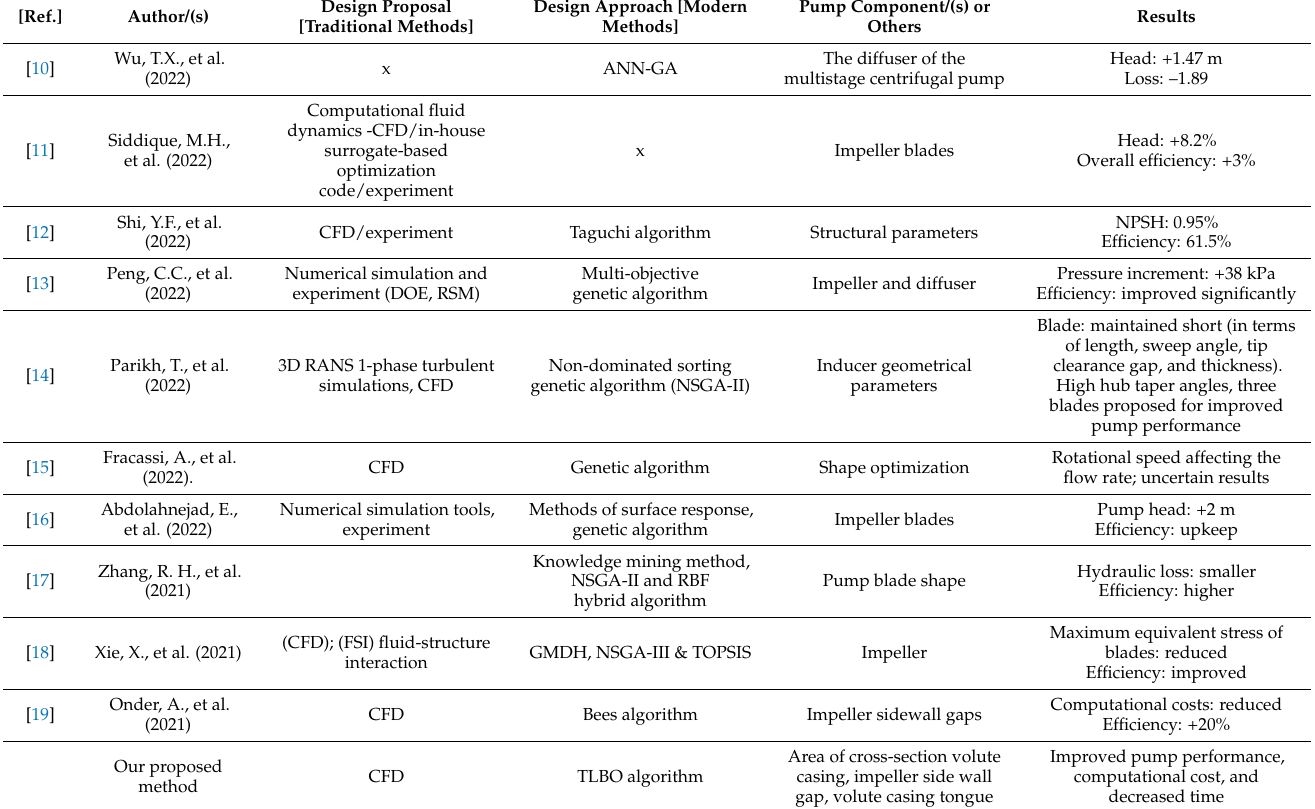
Table 1. A review of optimal design methods for centrifugal